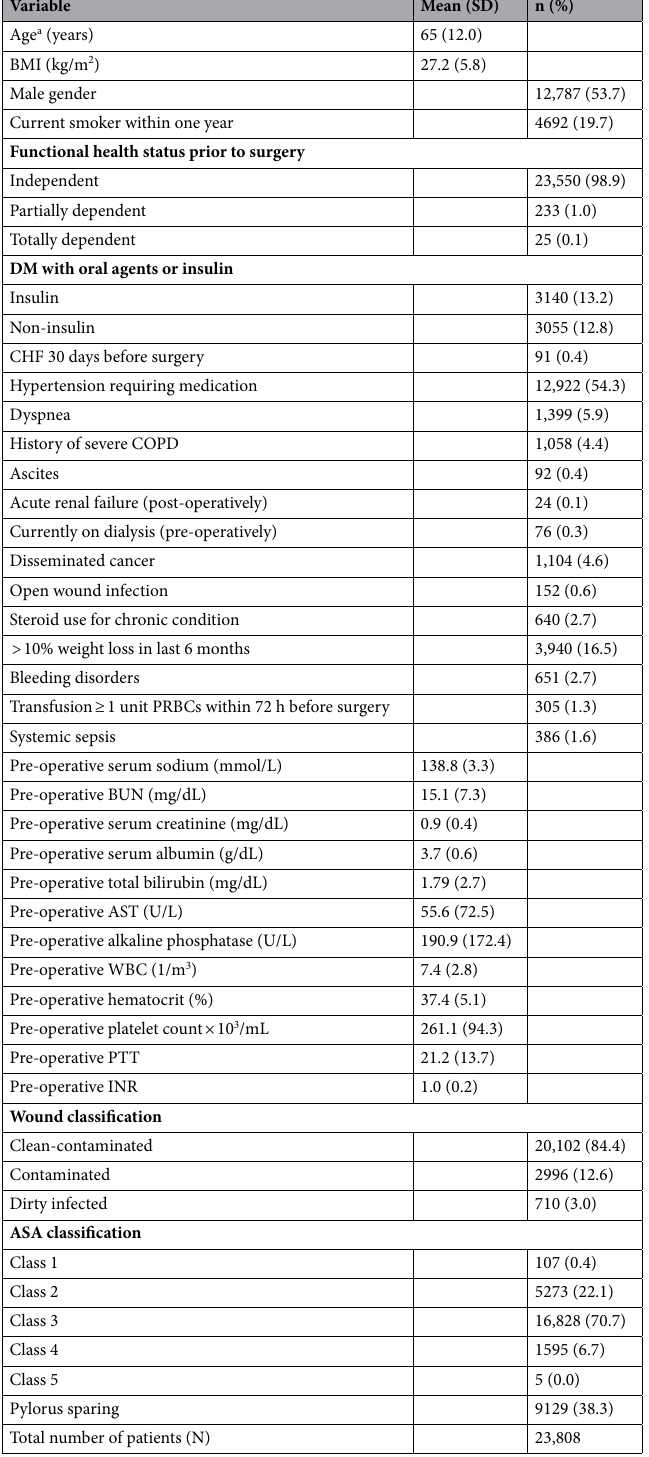
Table 2. Demographic characteristics of the cohort. SD standard deviation, BMI body mass index, DM diabetes mellitus, CHF congestive heart failure, COPD chronic obstructive pulmonary disease, pRBC packed red blood cells, BUN blood urea nitrogen, HCT hematocrit, WBC white blood cells, AST aspartate transaminase, PTT partial thromboplastin time, INR international normalized ratio, ASA American Society of Anesthesiologists. a With patients over 89 coded as